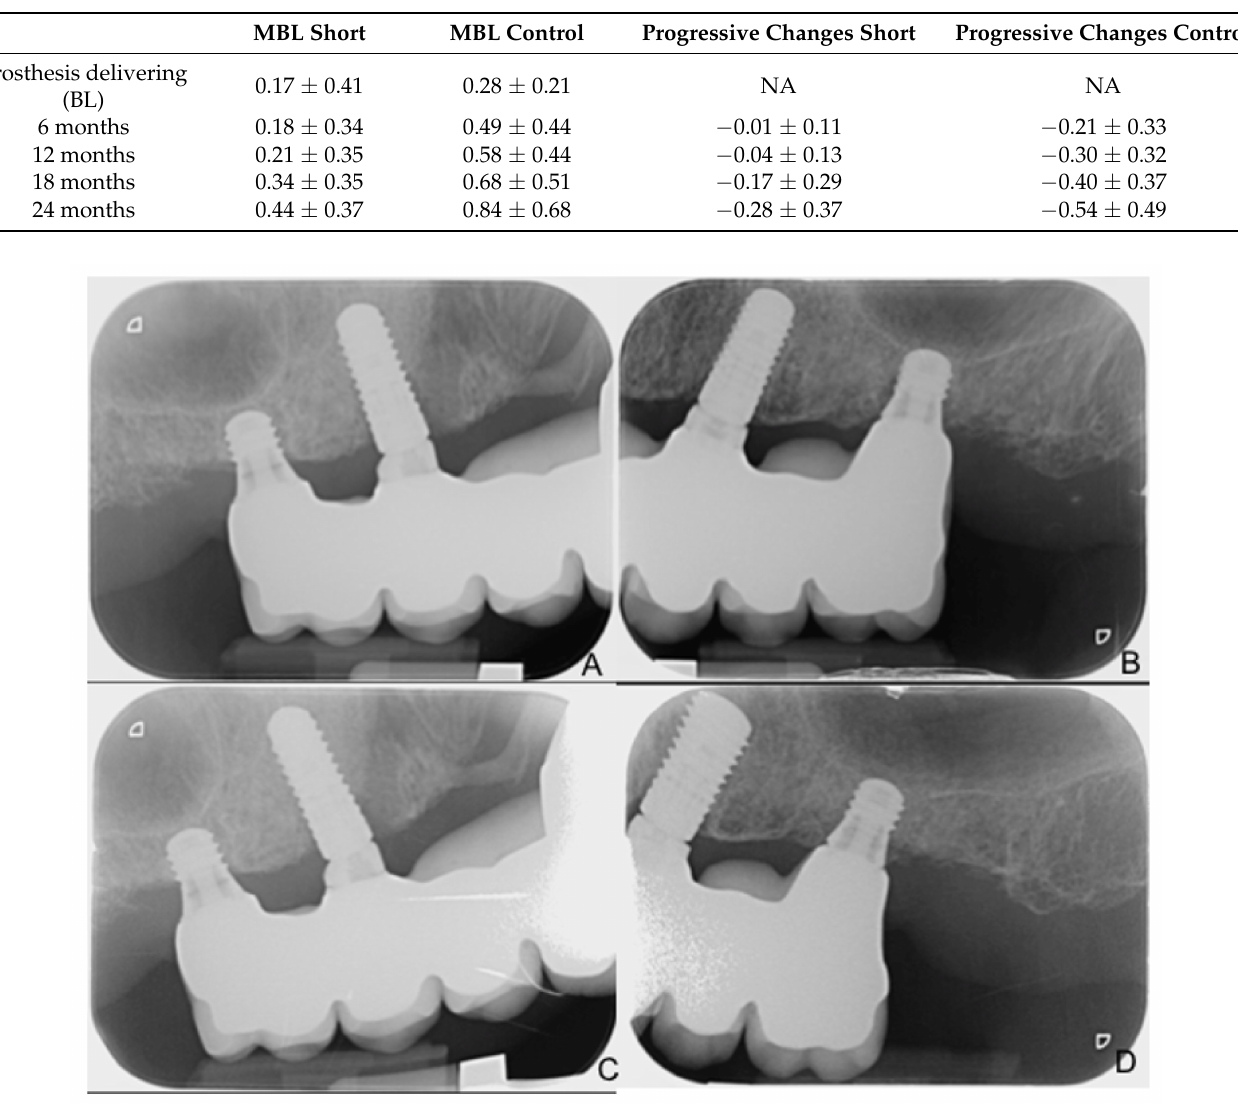
Table 2. Radiographic evaluation. Mean bone level (MBL), distance between the implant margin (M), and the first bone-to-implant contact (B). Evaluation performed at implant level.